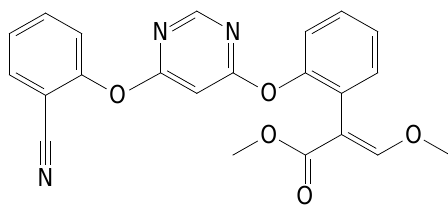
Figure 1. Chemical structure of azoxystrobin.